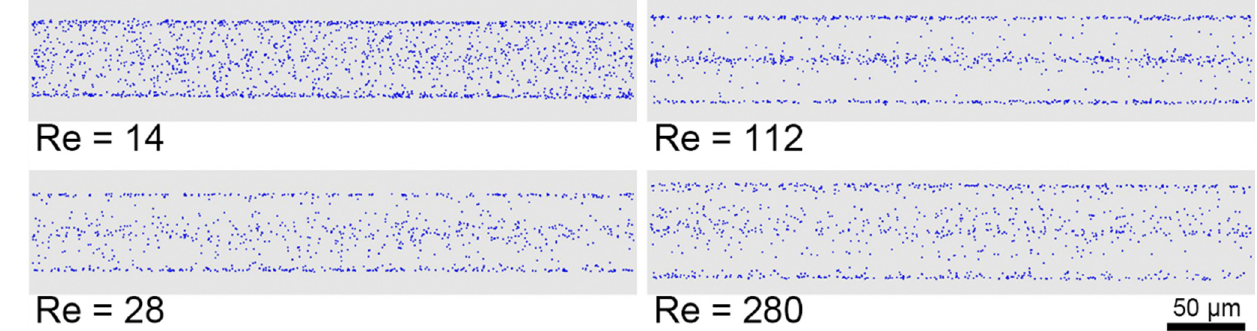
Figure 2. Overall particle distributions observed from the channel midplane for different Re at a distance z/H = 1000 from the channel inlet and for particles of diameter d p = 8.44 µm and a particle volume fraction Φ = 0.05%.